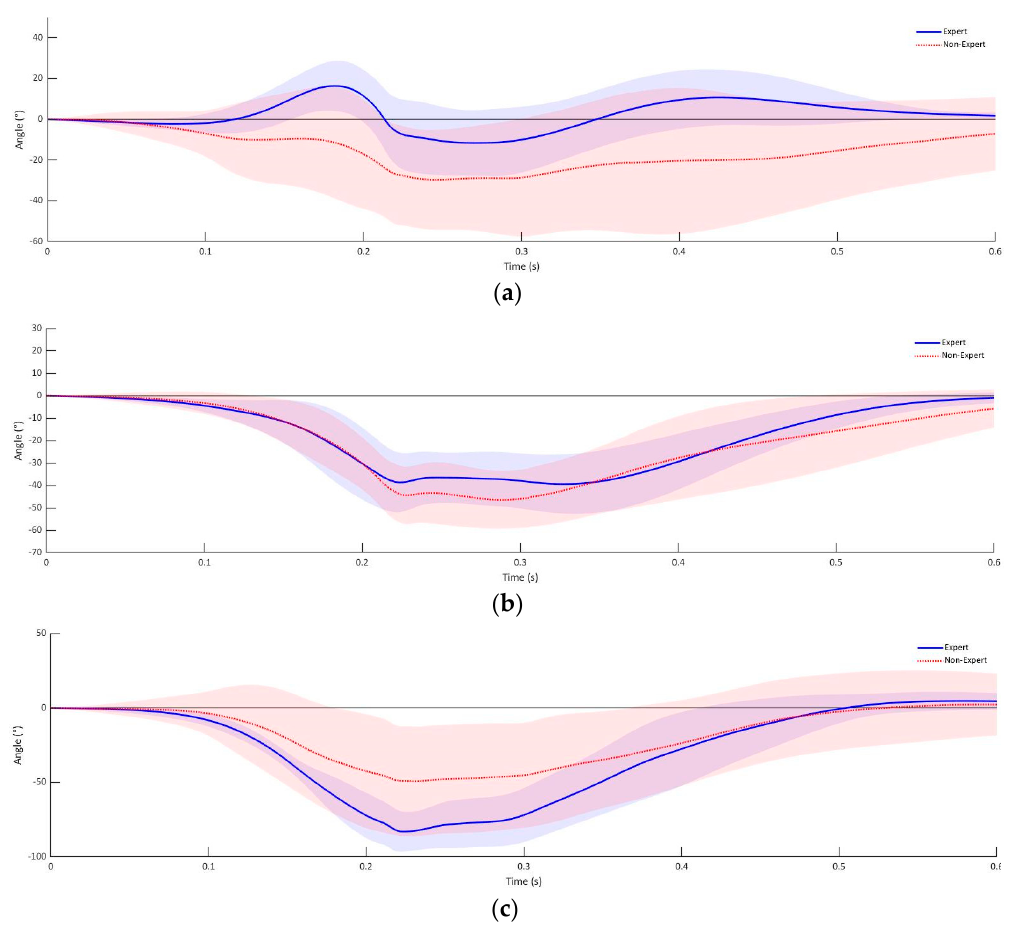
Figure 6. Fist rotation experienced athletes jab punch: ( a ) longitudinal, ( b ) transversal and ( c ) sagittal axis. As shown in Table 4, a deviation of the fist orientation in three-dimensional space of 6.14 ◦ (SD = 8.47 ◦ ) in the longitudinal axis, − 6.16 ◦ (SD = 4.3 ◦ ) in the transverse axis and 1.4 ◦ (SD = 2.8 ◦ ) in the sagittal axis is shown between the first defensive position before the punch is executed to the defensive position after the impact was executed for the group of experienced participants. With an average difference of 8.34 ◦ to the experienced group, the retracted defensive position of the non-experienced group of subjects is set with a deviation of − 2.2 ◦ (SD = 15.43 ◦ ) from the initial defensive position (Table 4). In addition, the retracted defensive position deviates from the initial position by − 9.63 ◦ (SD = 11.47 ◦ ) in the transverse axis and − 7.24 ◦ (SD = 18.34 ◦ ) in the sagittal axis (Table 4). This corresponds to a mean difference from the experienced group by 3.47 ◦ in the transverse axis and 8.64 ◦ in the sagittal axis. The results presented do not show statistically significant differences between the two groups of subjects. Table 4. Difference in angular orientation between the initial and retracted defensive position jab punch.